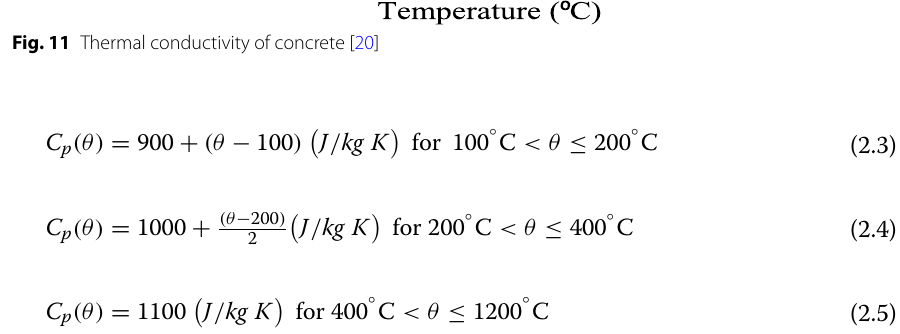
Fig. 11 Thermal conductivity of concrete